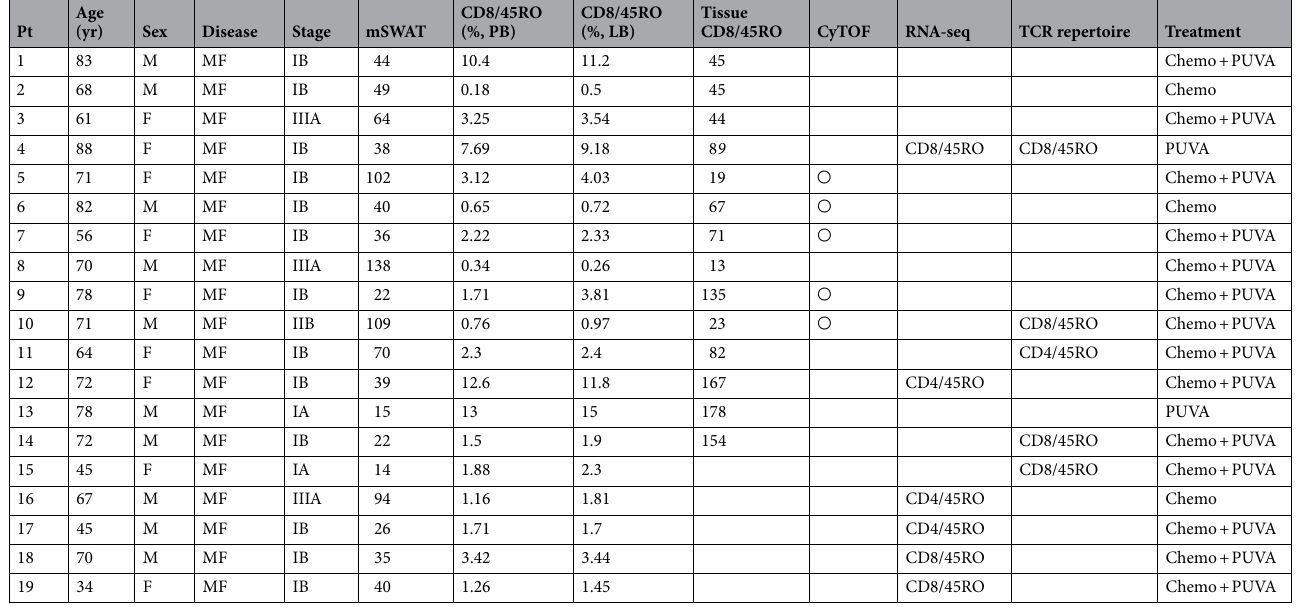
Table 1. Patient background. All MF patients are CD4 + MF and underwent skin biopsies on